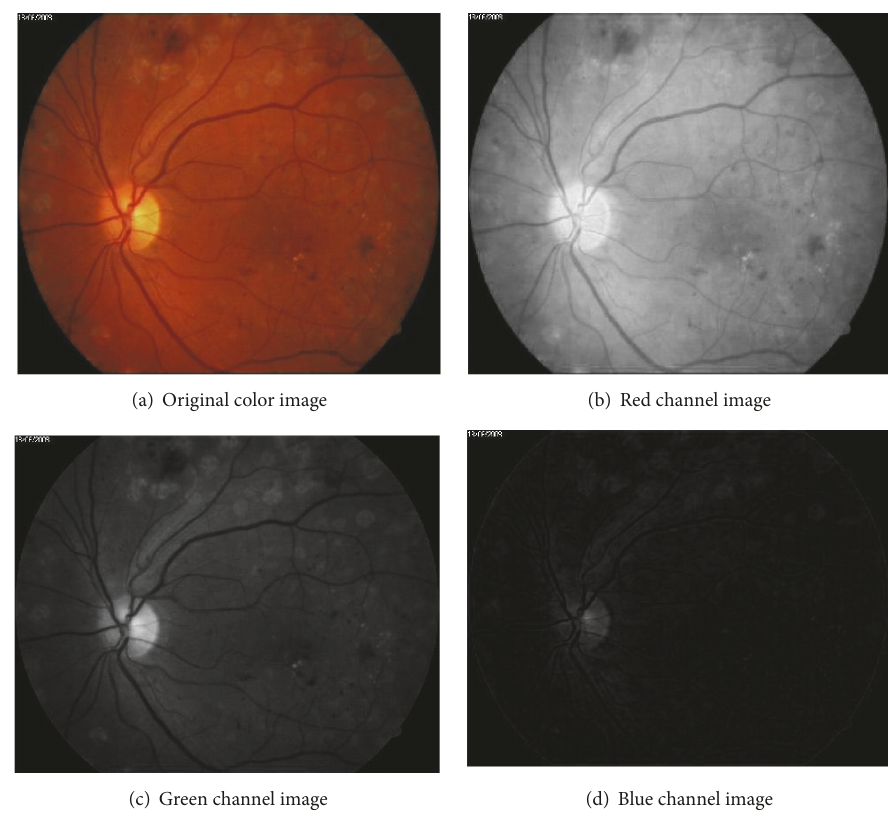
Figure 4: Original image: (a) colors image and (b) red, (c) green, and (d) blue channel image.